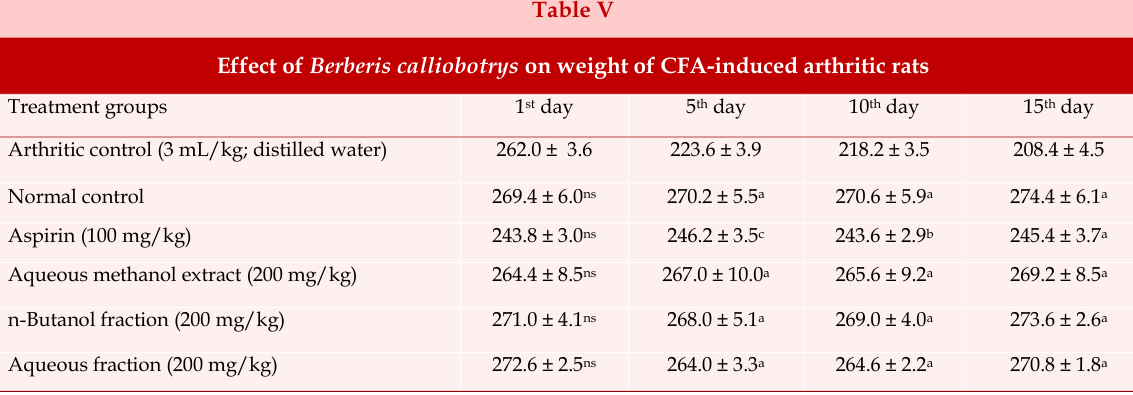
Effect of Berberis calliobotrys on weight of CFA-induced arthritic